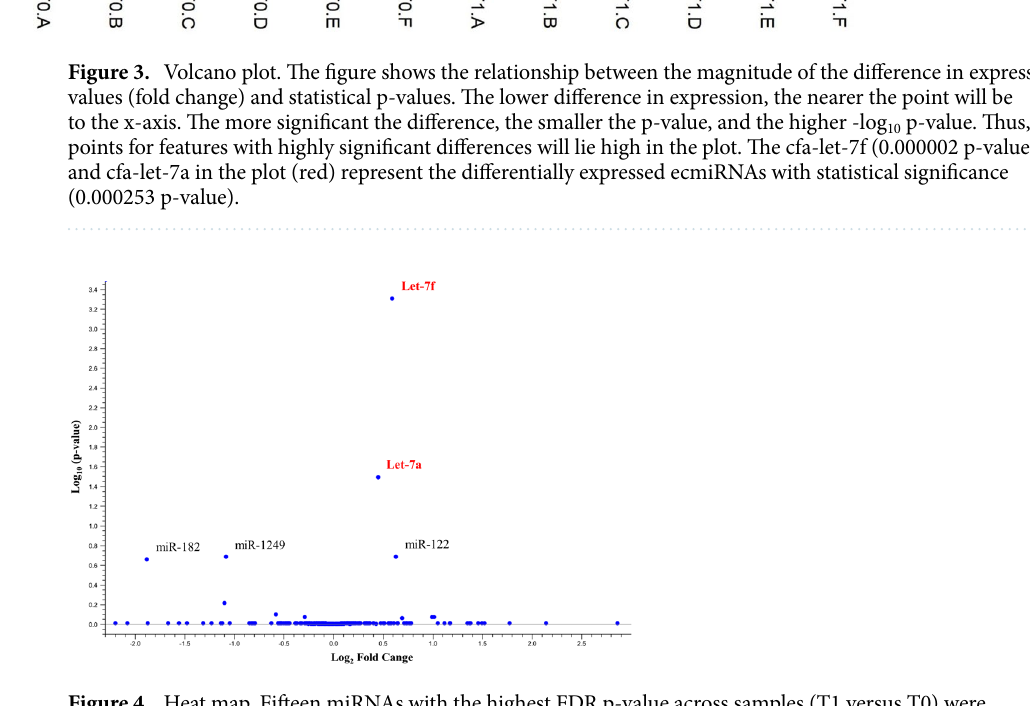
Figure 4. Heat map. Fifteen miRNAs with the highest FDR p-value across samples (T1 versus T0) were selected. Each row represents one miRNA, and each column represents one sample. The color represents the difference of the count value to the row mean. They are also called centered values. Red indicates high relative expression, and green indicates low relative